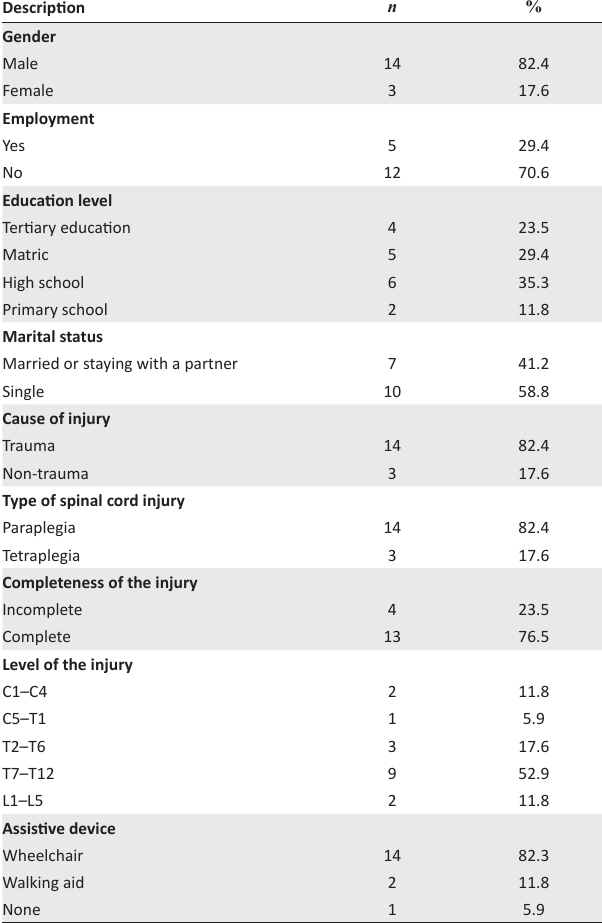
TABLE 1: Demographic profile of the participants ( n = 17).